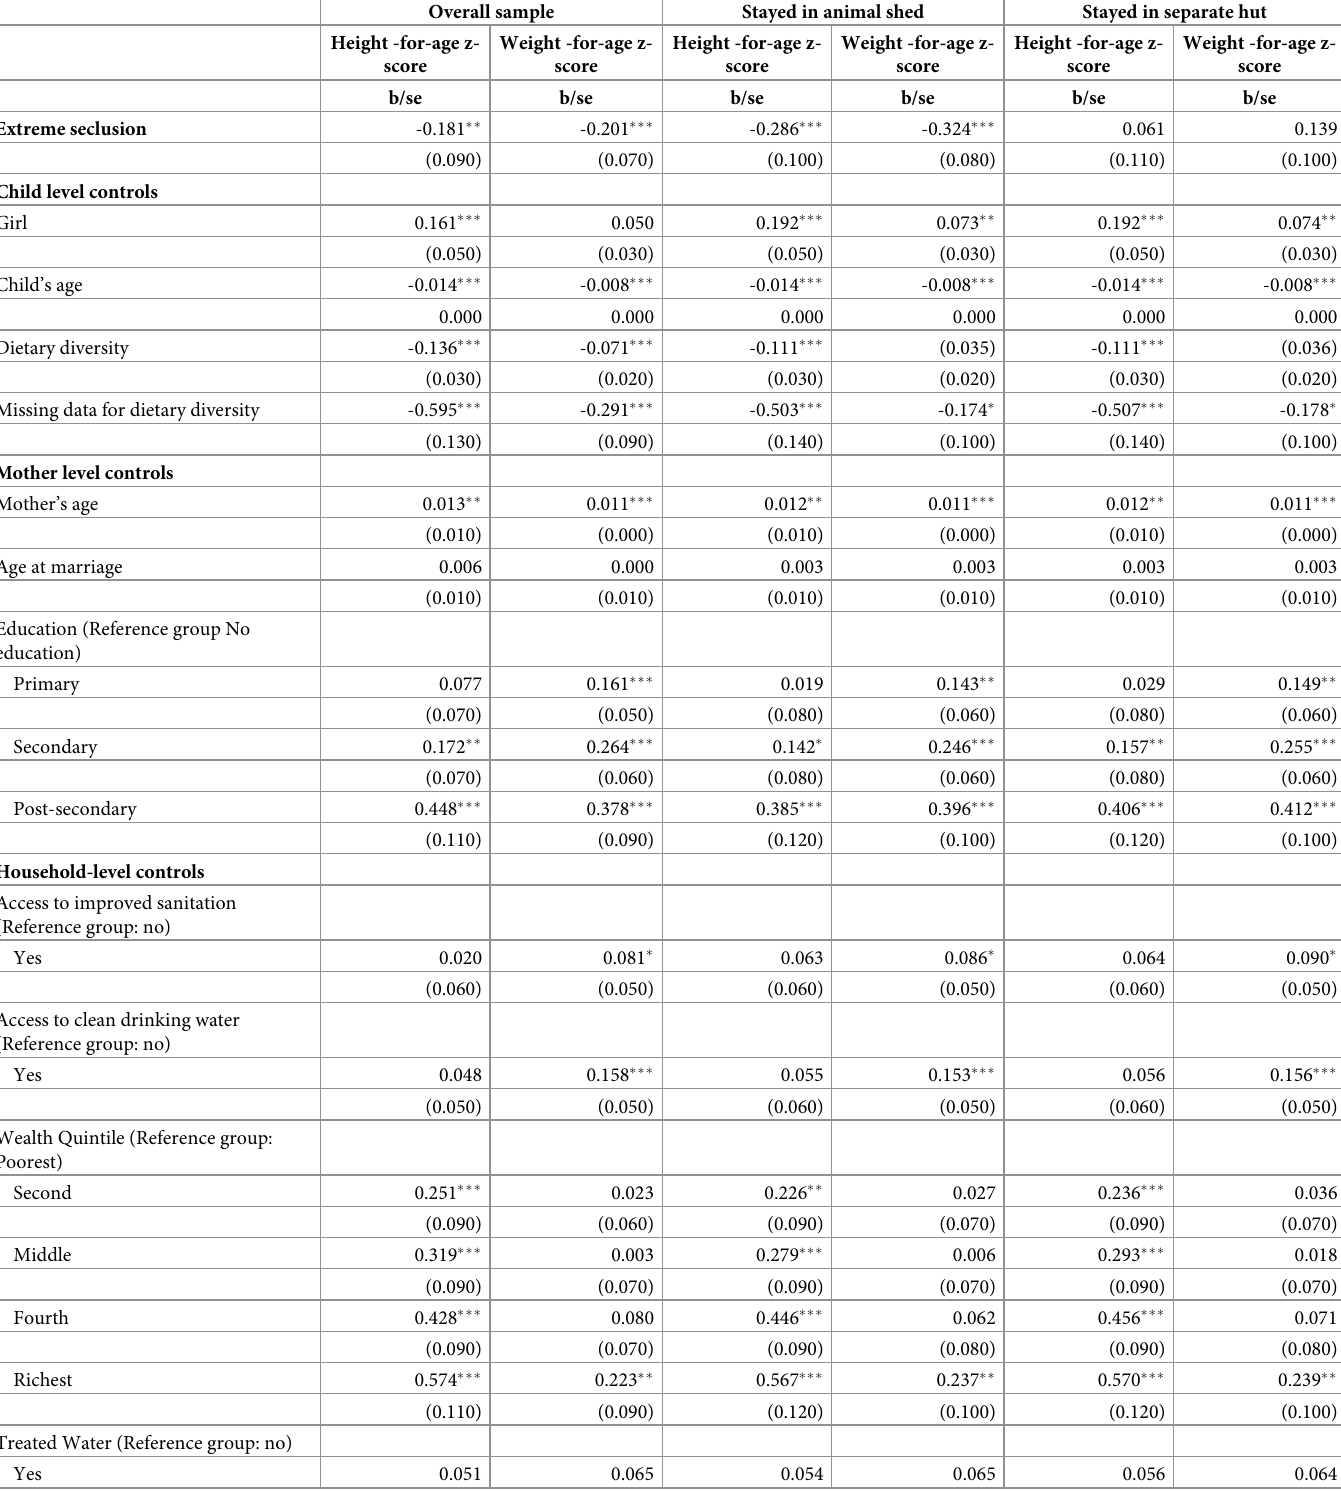
Table 2. Coefficients from linear regressions of height-for-age and weight-for-age Z-scores of children 5–59 months on whether the mother stayed separately in ani- mal shed or hut during